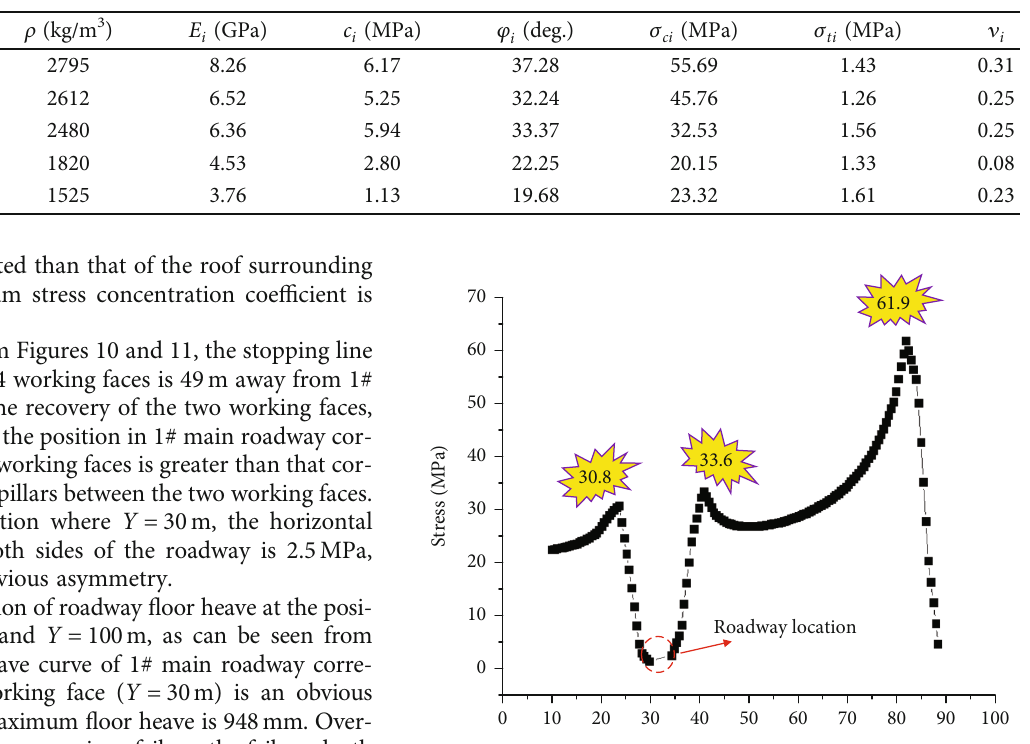
Table 1: Mechanical parameters of coal and rock.